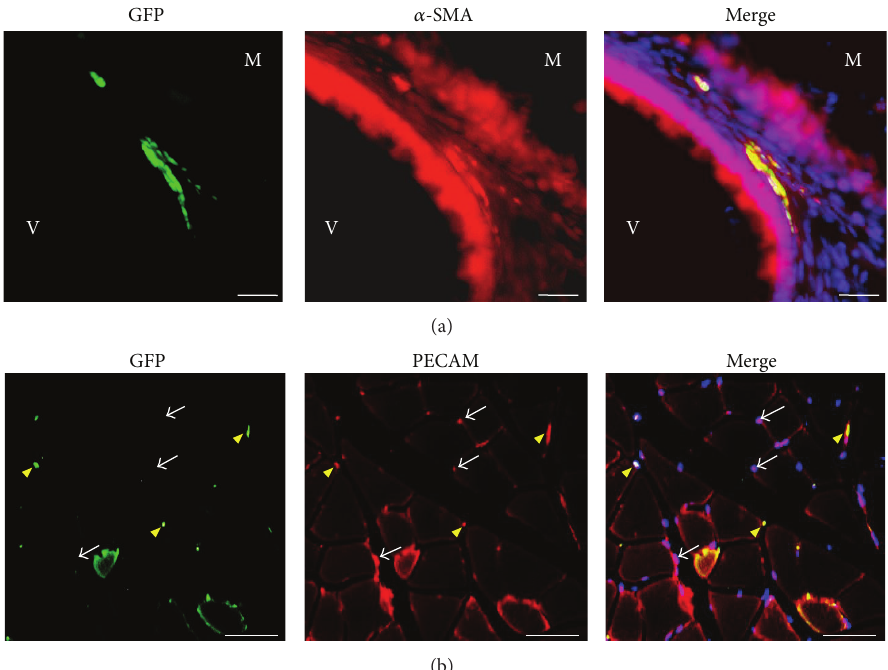
Figure 5: The transplanted angioblast-like cells induced from ES cells (ES-ABs) constructed blood vessel walls and capillaries. Immunohisto- chemical staining revealed that transplanted GFP-expressing ES-ABs were still engrafted 4 weeks after transplantation. (a) The engrafted cells distributed in vessel wall between hindlimb muscle fibers and coexpressed 𝛼 -SMA. Green: GFP and red: 𝛼 -SMA. M: muscle and V: lumen of a blood vessel. Bar: 20 𝜇 m. (b) Some of GFP positive cells resided in gaps between soleus muscle fibers and coexpressed PECAM. Green: GFP and red: PECAM. White arrows: GFP negative capillaries and yellow arrowheads: GFP positive capillaries. Bar: 20 𝜇 m.